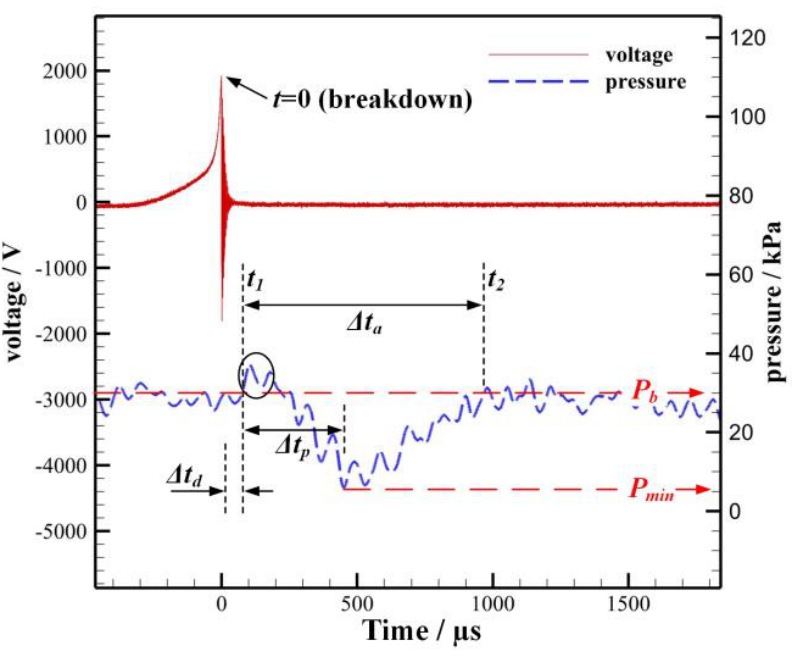
Figure 5. Change curves of discharge voltage and ramp wall pressure with time in case1.